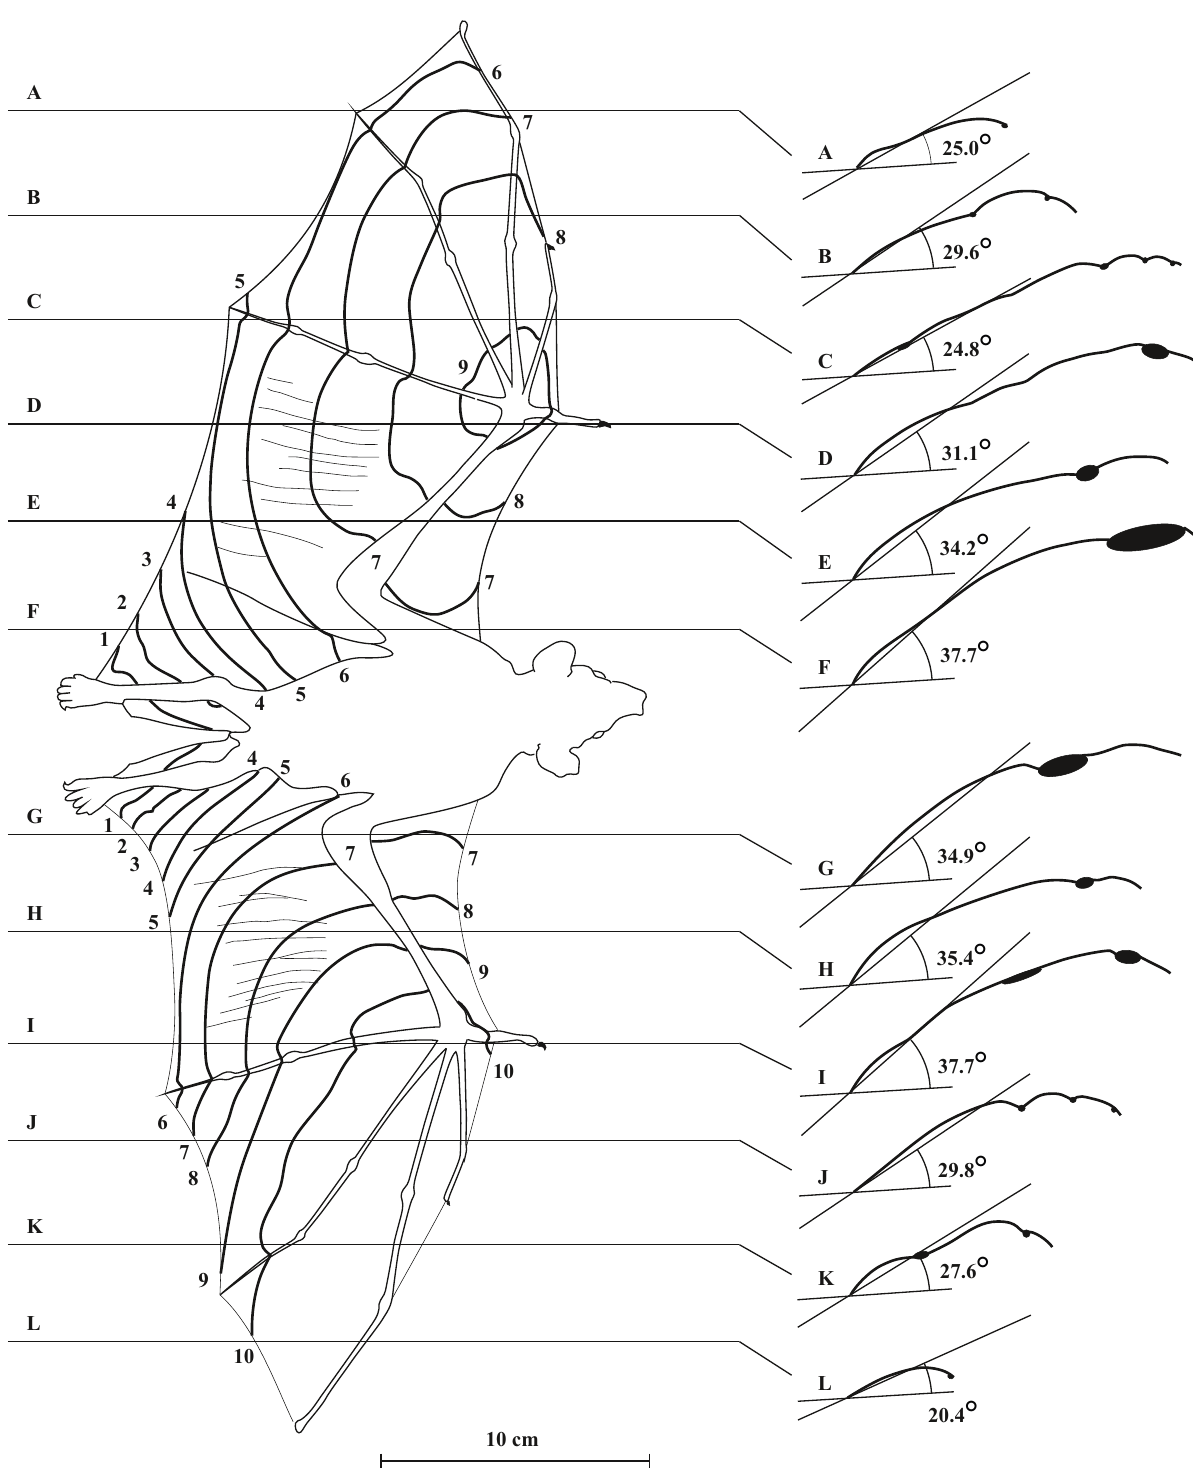
Figure 8. A Rousettus fruit bat gliding at Nairobi in the original Bristol blower tunnel, illuminated by a flashgun shining upwards through the wing. This is one frame of a stereo pair. All the strength comes from the bones of the skeleton, not from the membrane itself. The bat cannot adjust its wing in the manner of Figure 3, as this would unload the membrane. The thin muscles in the membrane, which do not attach to the skeleton, are used to flatten the wing profile at higher speeds. The sections are all convex at low speed, but the bat flew perfectly steadily, with no signs of